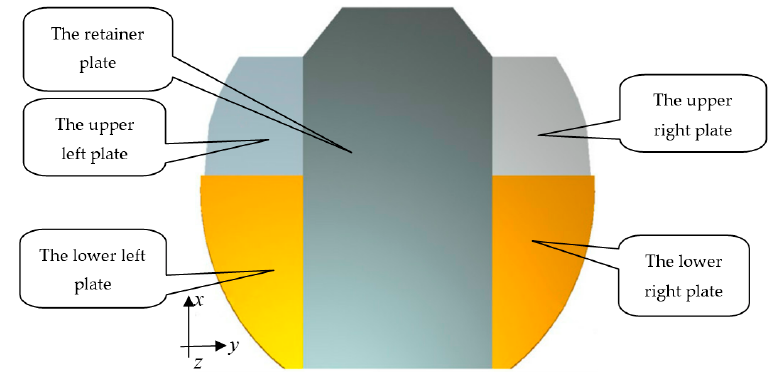
Figure 1. Schematic diagram of the deployed antenna.